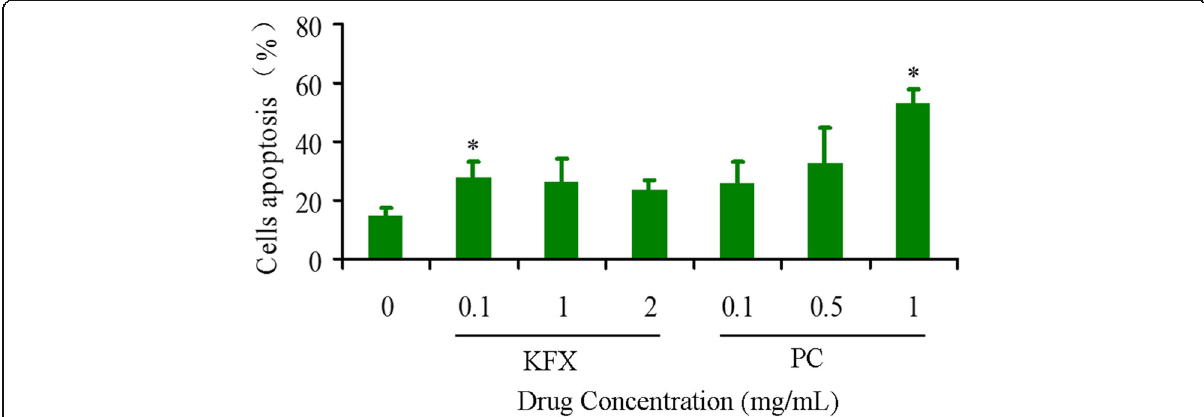
Fig. 4 KFX and PC substance induce apoptosis in osteoclasts. Cells are incubated with various concentrations of KFX and PC substance for 72 h, and then the induction of apoptosis is determined by Annexin V-FITC/PI staining analysis. Cell apoptosis data are quantified and presented as a